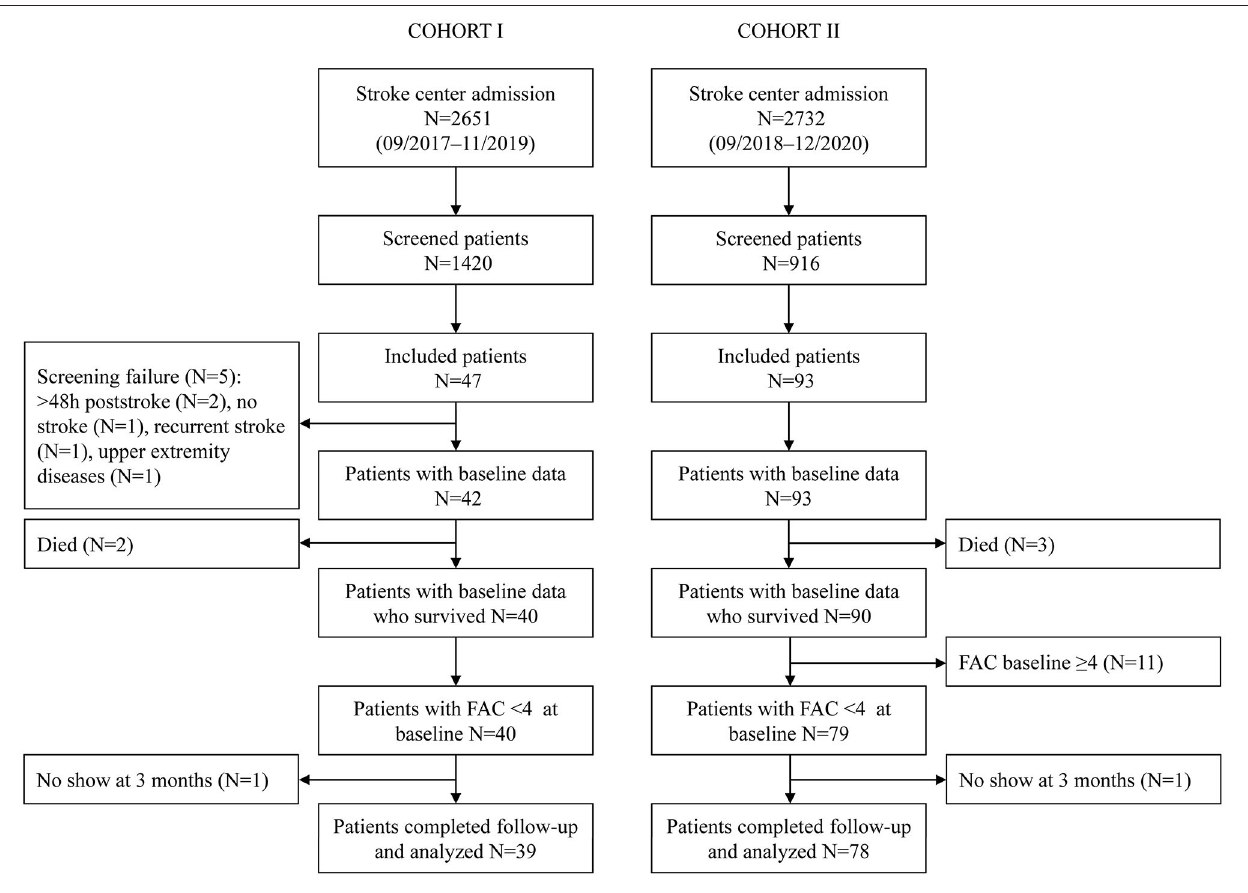
FIGURE 1 | Patient